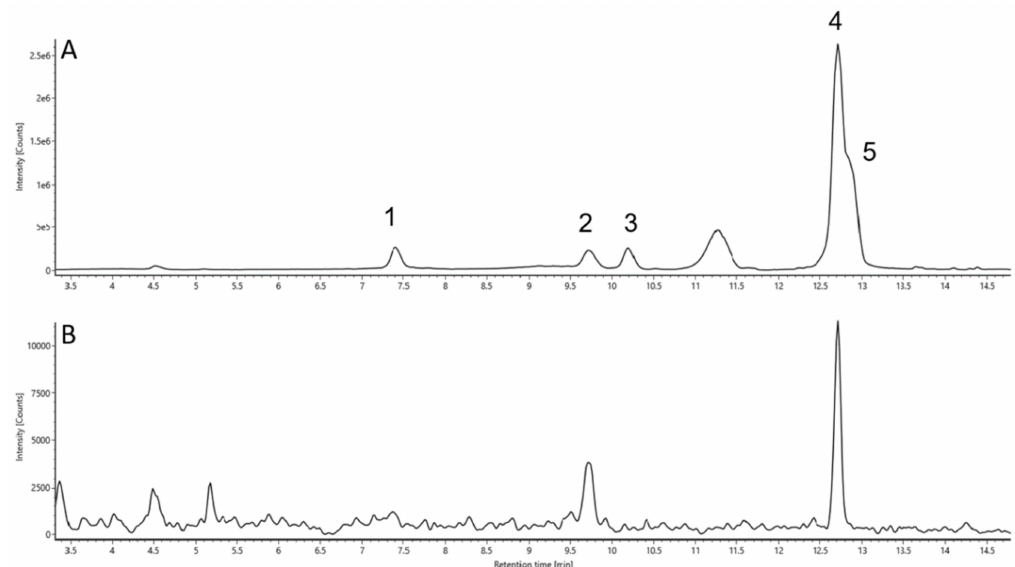
Figure 1. Extracted ion chromatograms of the [M] + , m / z 367.0118 (cyanidin monosulfate) after the synthesis reaction ( A ) and of the 24 h urine sample ( B